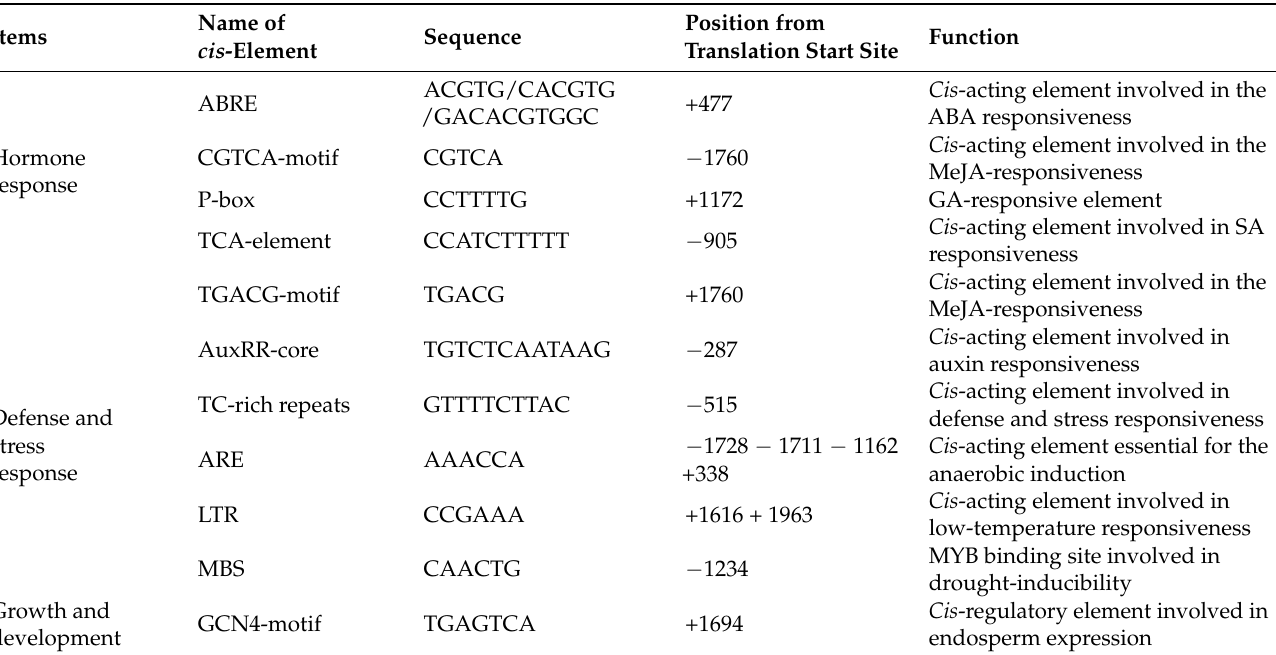
Figure 2. Sequence logos of the CmbHLH domains. The height of the amino acids at each site indicates the conservatism of the corresponding amino acids. Capitalized letters below the sequence logos indicate that more than 50% of amino acids are consistent in the conserved domain of all CmbHLH proteins. Table 2. Classification of cis -elements in the promoter sequences of the five UP CmbHLHs